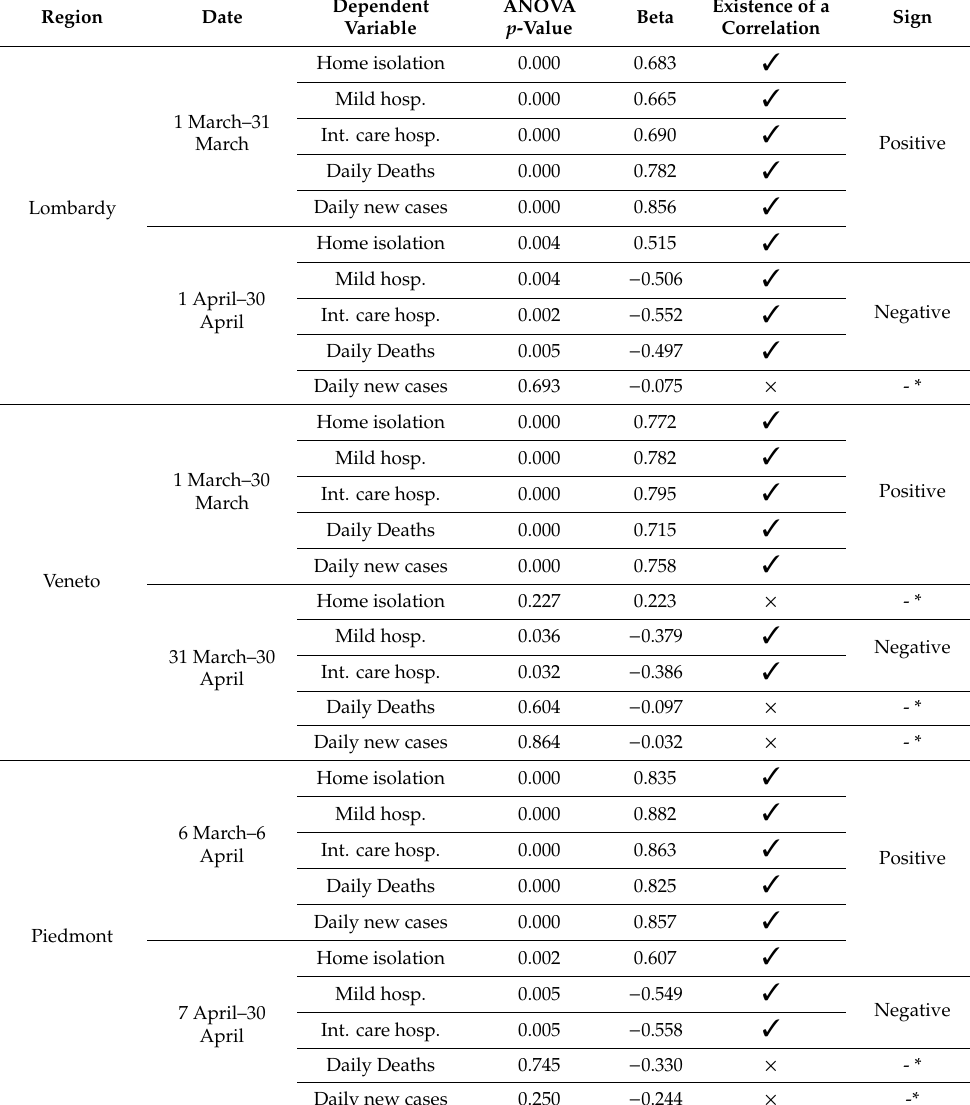
Table 5. Test No. (Independent variable) vs. each outcome variable within two time periods (Lombardy, Veneto, and Piedmont). Region Date